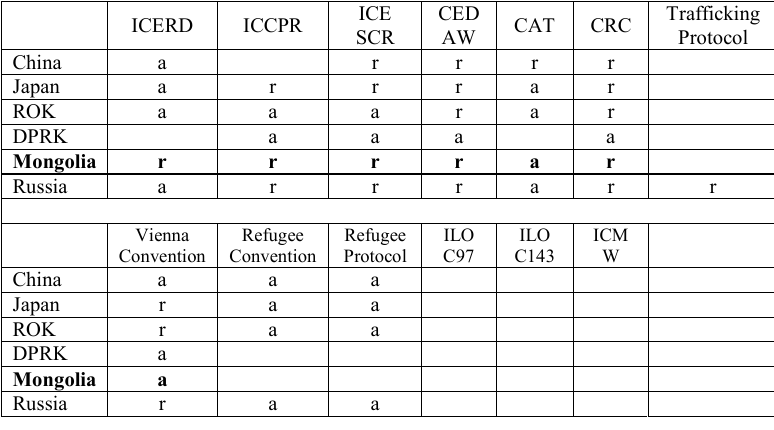
Ratification (r); accession (a); succession